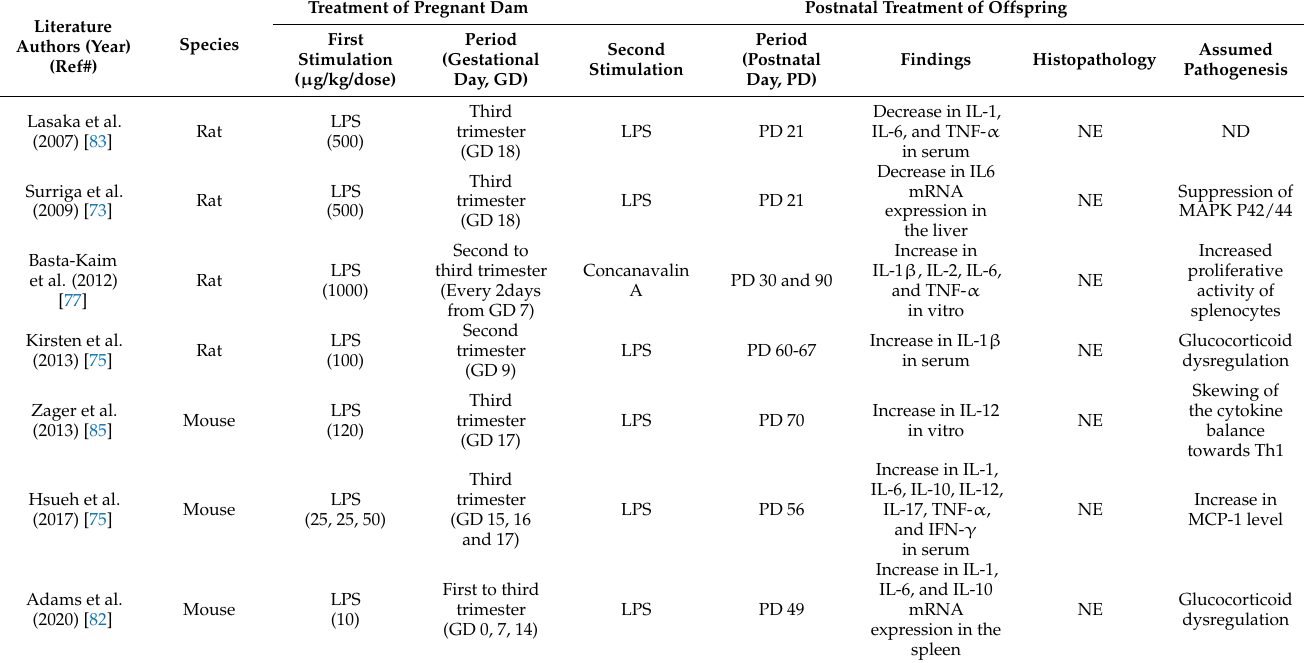
Table 2. Association between MIA using LPS and immune disorders caused by postnatal inflamma- tory